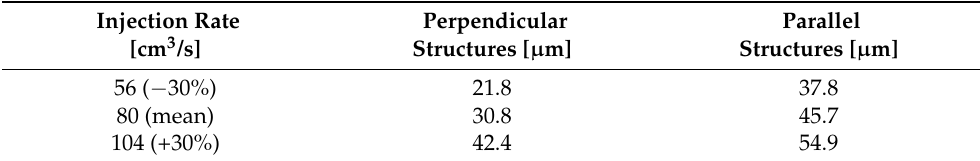
Table 4. Mean heights of microstructures on polymer